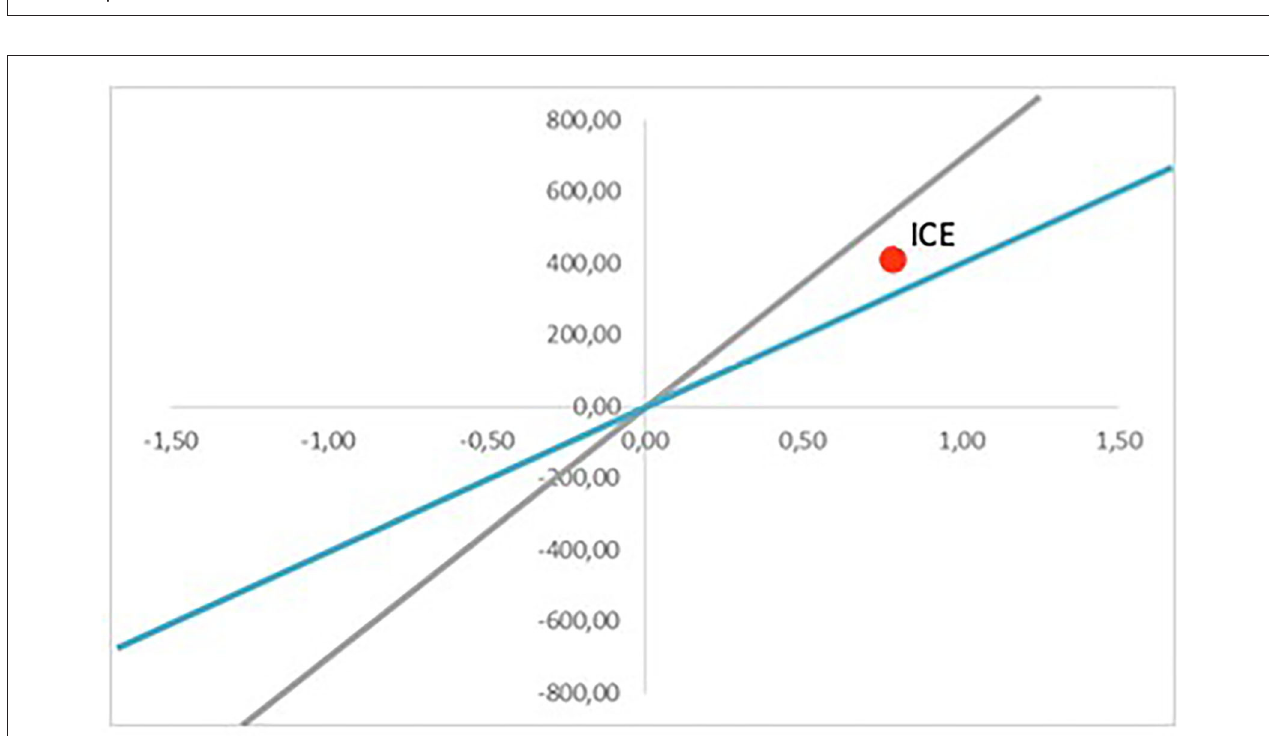
FIGURE 7 | Cost-effectiveness plan (Scenario